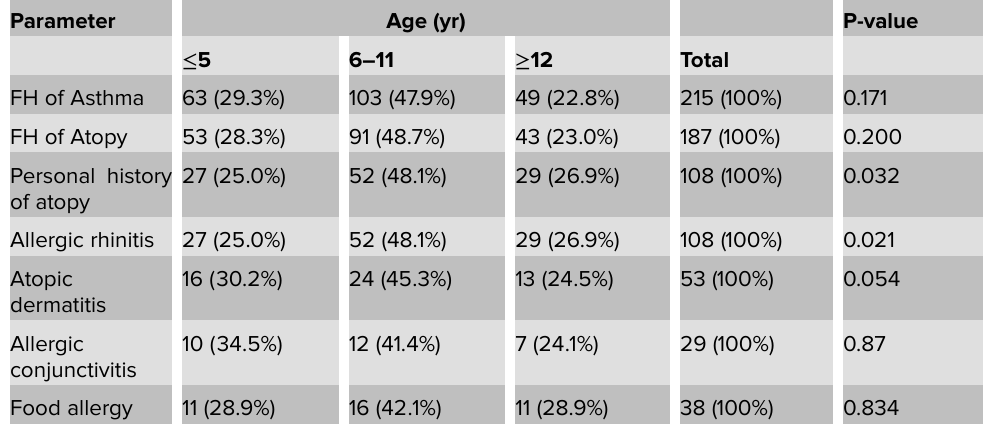
Table 3: Association between the allergens with age ( N =